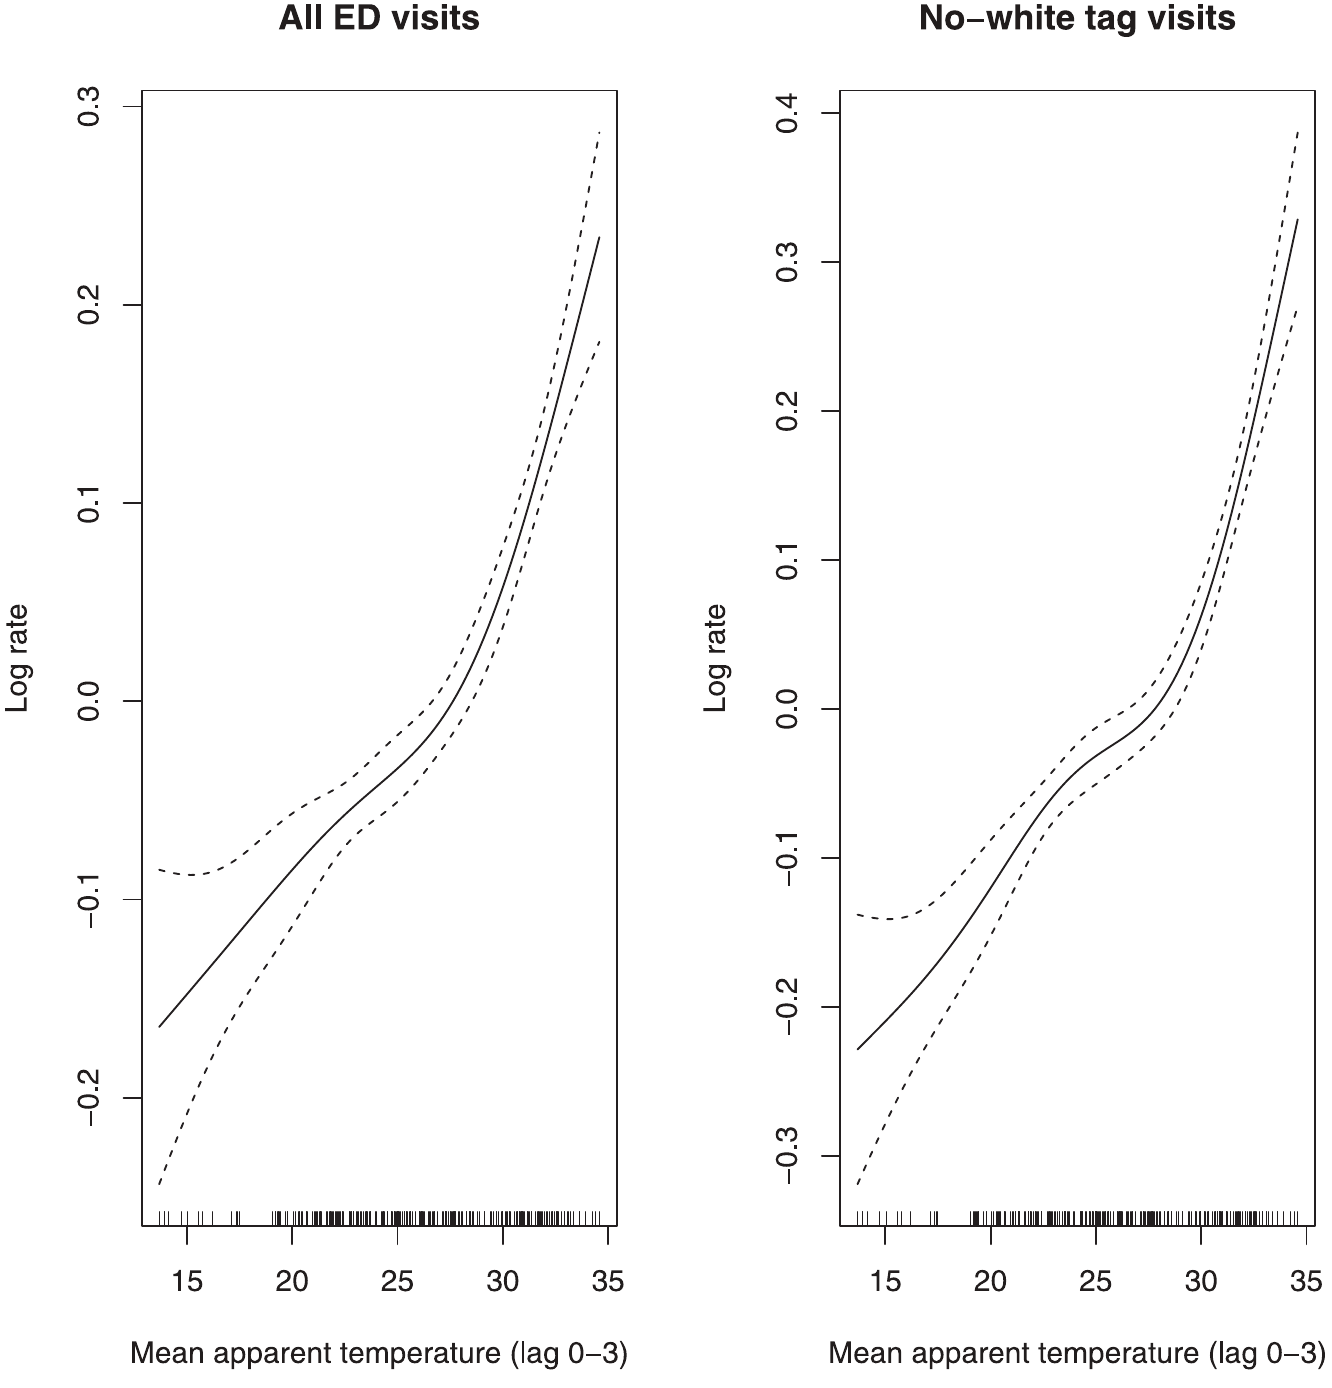
Fig 1. Estimated heat-response curves and 90% confidence bands for all the ED visits and for no-white tag visits at lag 0 – 3. The maximum likelihood approach provided stable estimates of the threshold even when using different starting points for the algorithm [32]. When considering all ED visits, the threshold was equal to 28.6°C (90% CI: 28.5°C; 28.7°C). When considering the subgroup of no white tag visits, the threshold did not change: the estimated threshold was equal to 28.81°C (90% CI: 28.7°C; 28.9°C).